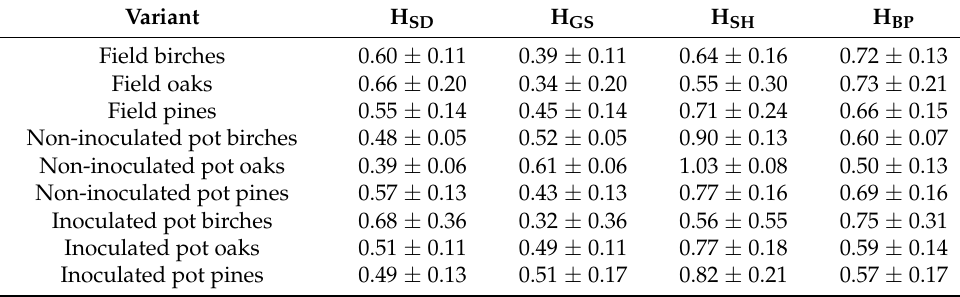
Figure 2. Morphotypes observed on non-inoculated pot plants. Birch roots with ( A ) non-identified B_non_inoc_MT1, ( B ) non-identified B_non_inoc_MT2, ( C ) non-identified B_non_inoc_MT3, ( D ) non-identified B_non_inoc_MT4, ( E ) non-identified B_non_inoc_MT5; oak roots with ( F ) non-identified O_non_inoc_MT1, ( G ) non-identified O_non_inoc_MT2, ( H ) Meliniomyces ; pine roots with ( I ) Inocybe lacera , ( J ) non-identified P_non_inoc_MT2, ( K ) non-identified P_non_inoc_MT3, ( L ) non-identified P_non_inoc_MT4. Bar always represents 1.0 mm. Table 2. Diversity indices calculated for ectomycorrhizal fungi communities in different variants of the